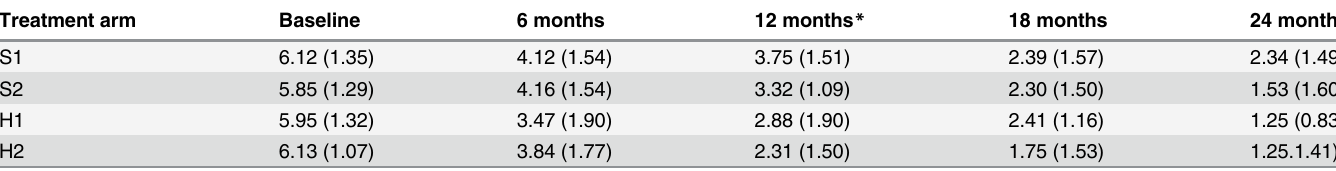
* p = 0.028 Overall there is a signi fi cant difference between the treatment arms. One way ANOVA was performed on the log transformed values to demonstrate any statistical signi fi cance in the effect of increasing dose or frequency of administration.